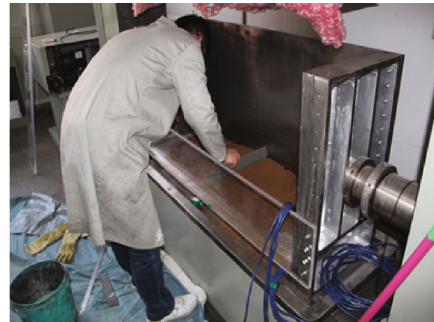
Figure 10: Unexcavated similar material model.